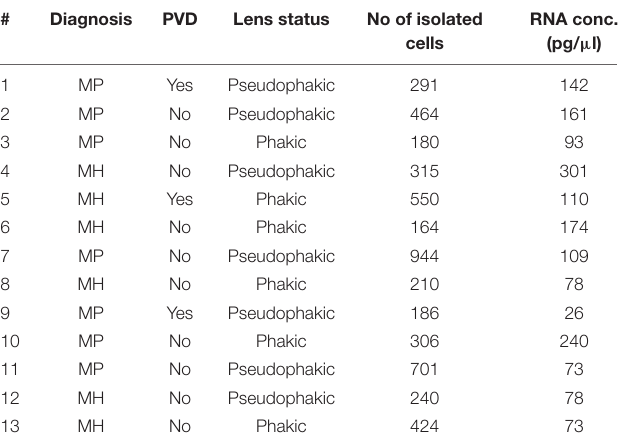
TABLE 1 | Patients’